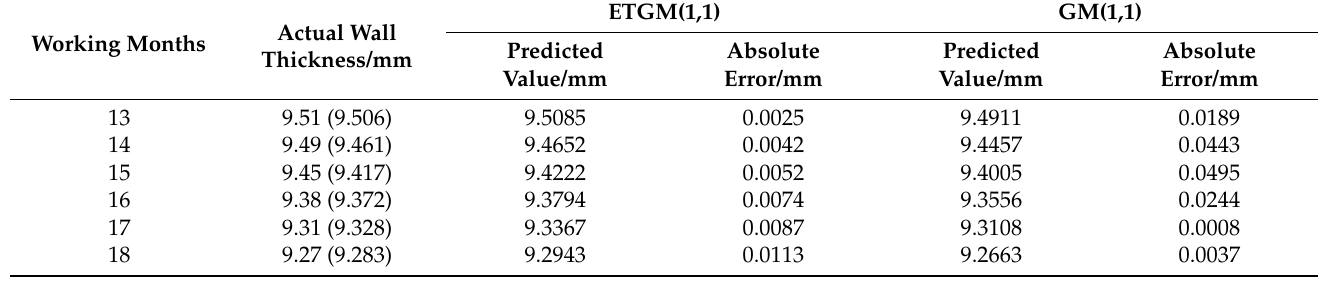
Table 4. The predicted results obtained by ETGM(1,1) and GM(1,1).